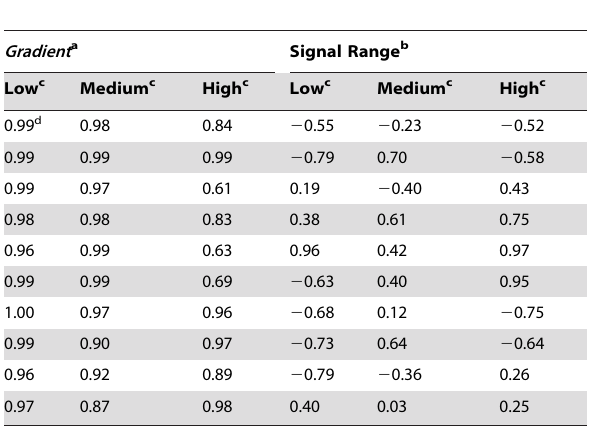
Table 4. Correlation coefficients between [MAPKK] total and Gradient /Signal